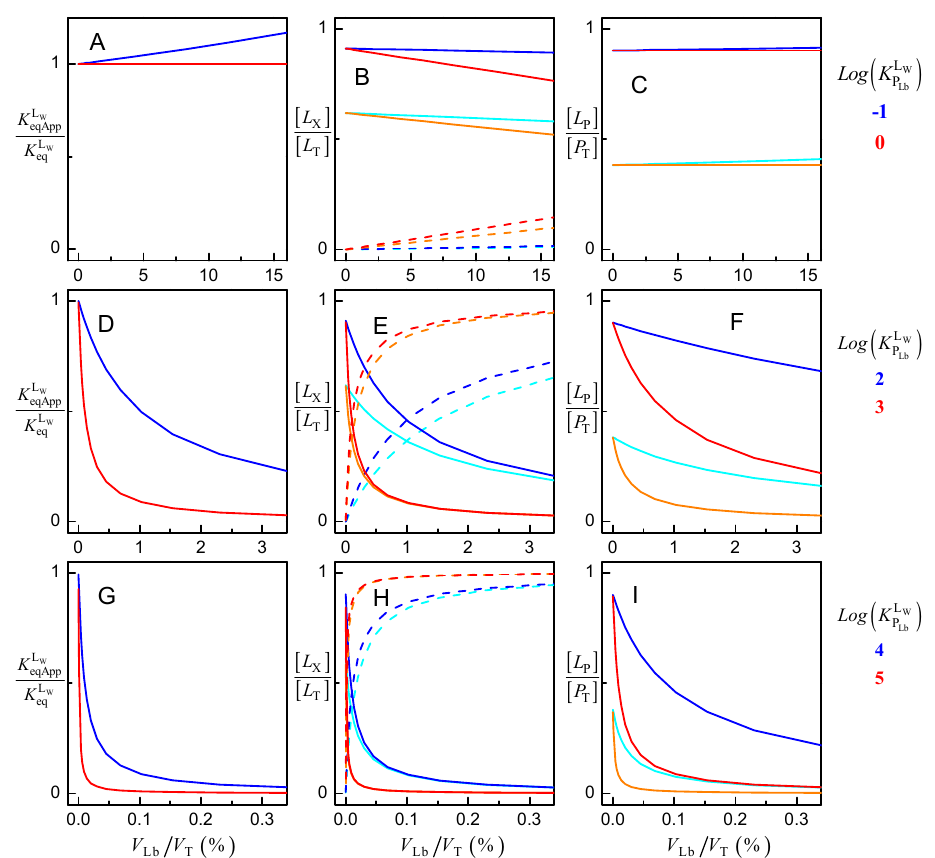
Figure 5. Effect of the volume of the lipid bilayer on the equilibrium association of ligand with a protein with M W = 50 kDa, P T = 1 µ M and K L W eq = 10 6 M − 1 for different ligand lipophilicity, as indicated in the figure. The variation of the apparent binding affinity is shown in the left plots ( A , D , G ), the fraction of ligand in the aqueous medium (continuous lines) and in the lipid bilayer (dashed lines) is shown in the middle plots ( B , E , H ), and the protein saturation with ligand is shown in the right plots ( C , F , I ); for [ L T ] = 1 µ M (light colors) and 10 µ M (dark